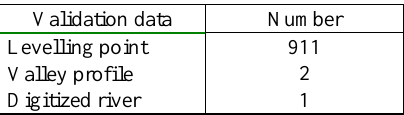
Table 1. Reference data used in the study